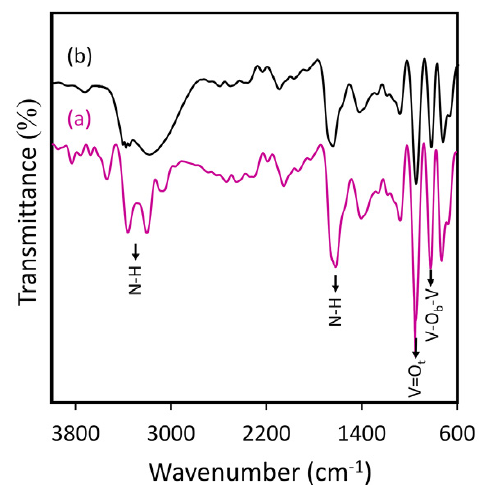
Fig. 6 (a) The simulated pattern based on single-crystal X-ray diffraction data of 1 , XRD patterns of nanoscale 1 formed by different water to ethanol volume ratios: (b) 1:1 and (c)